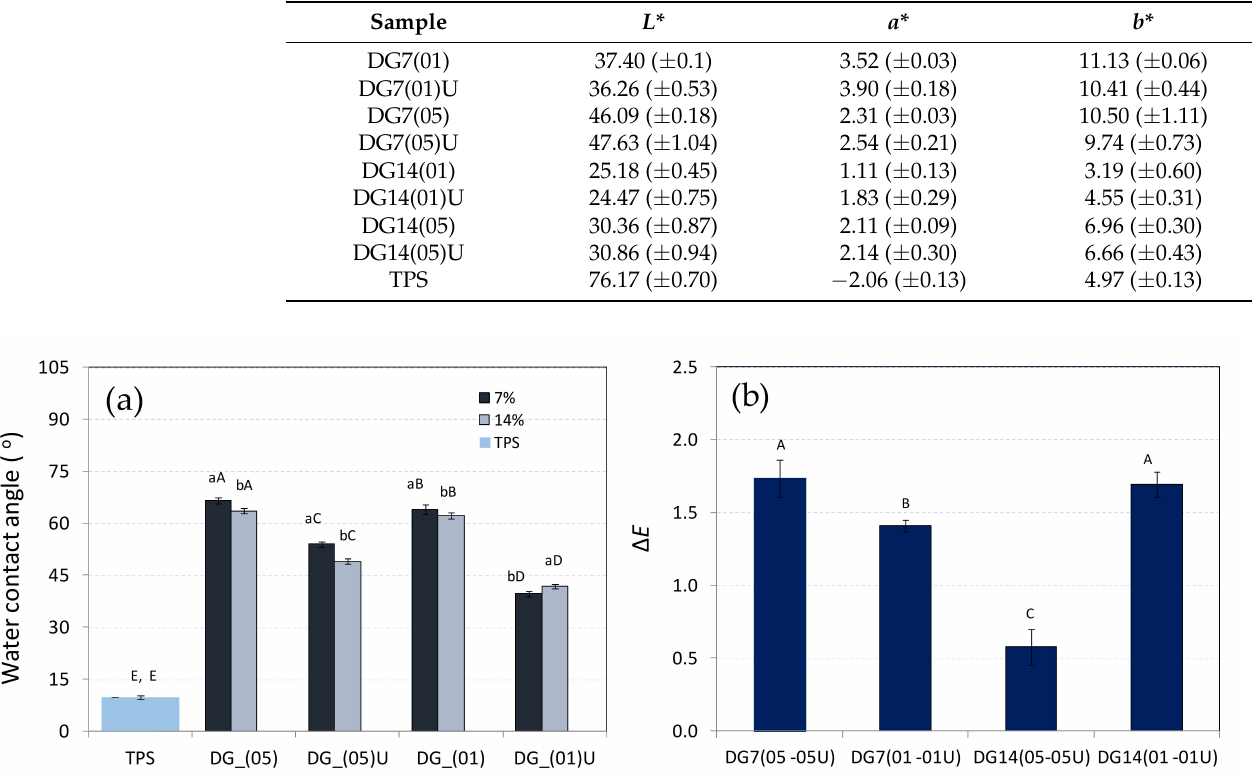
Table 3. Average values of the L *, a *, b * colour components. Five replicate measurements ( p < 0.05).